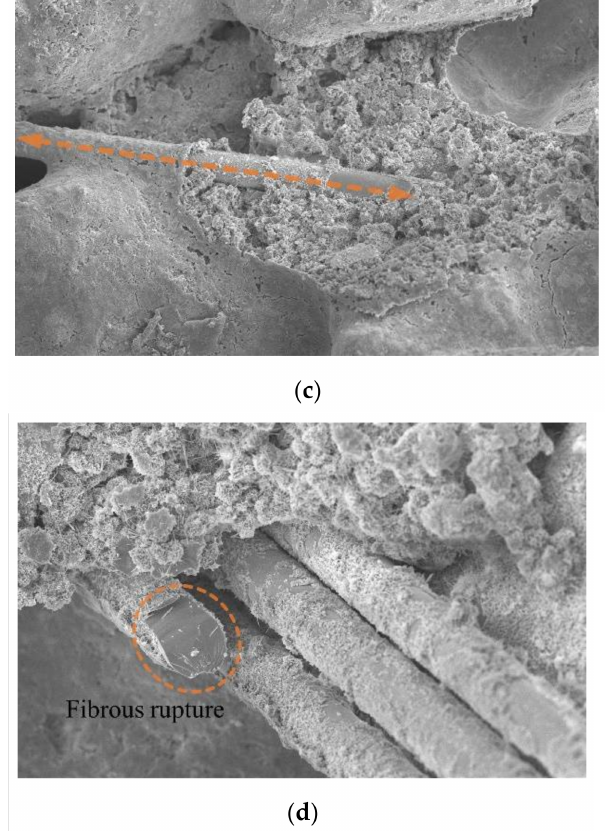
Figure 11. Fiber failure modes. ( a ) Image of the bond condition between the fibers and sand (500 × ); ( b ) Slip and dislocation at the interface between the reinforcement and sand (1000 × ); ( c ) Image of the bond condition between the fiber and sand (500 × ); ( d ) Fiber breakage (1000 ×